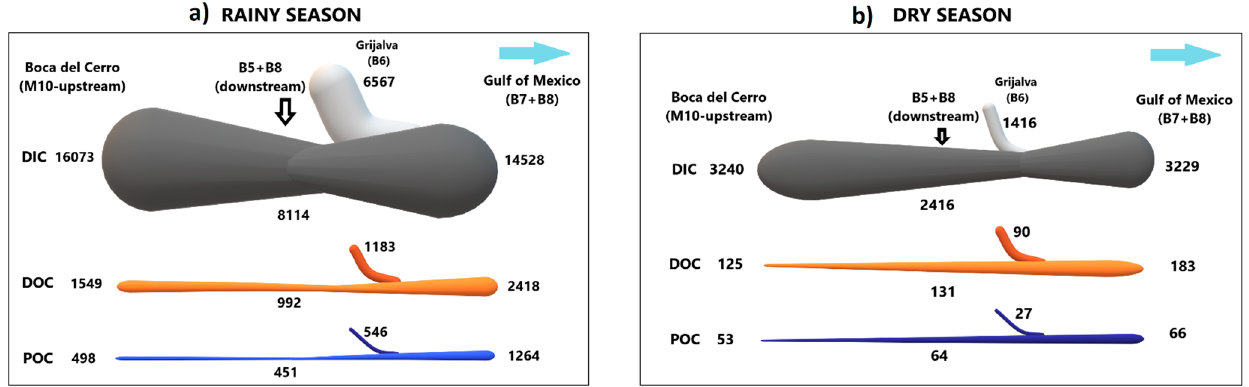
Figure 8. Application of the conceptual framework to the carbon flux (t d − 1 ) balance during the ( a ) rainy and ( b ) dry seasons in the lower basin of the Usumacinta River. The widths of the lines, proportional to the magnitude of the fluxes, are consistent within one season but not between the different seasons.